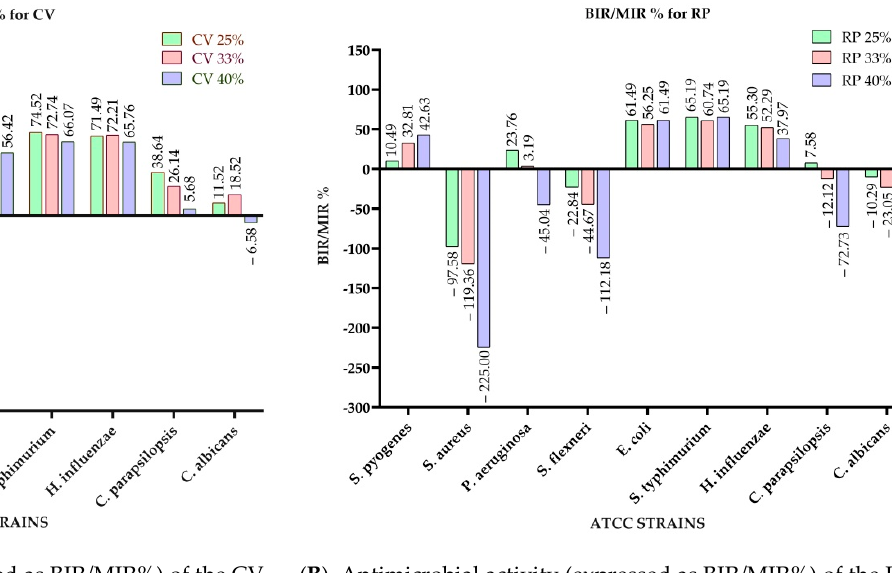
( B ). Antimicrobial activity (expressed as BIR/MIR%) of the RP extract.